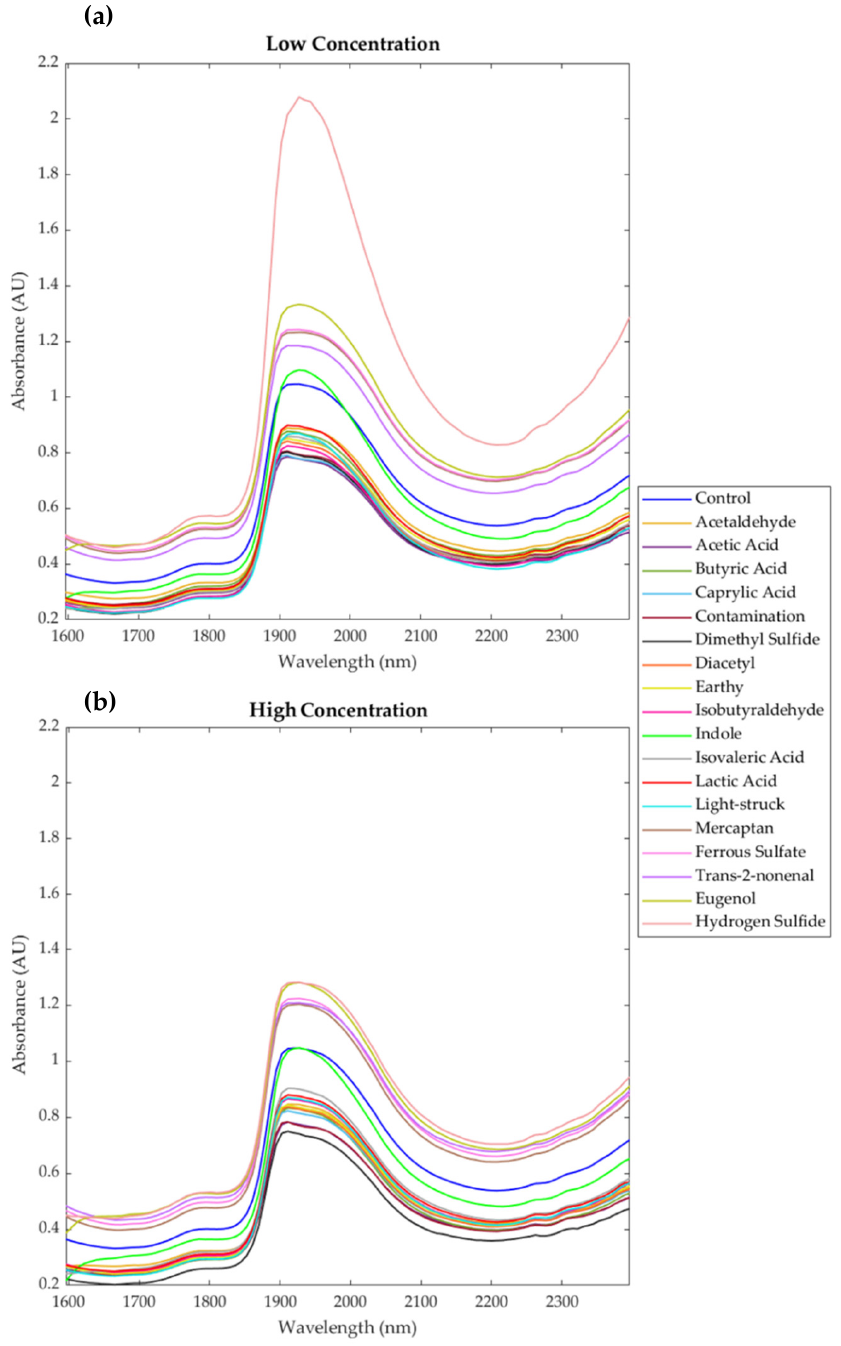
Figure 2. Near-infrared curves for all beer samples using the raw absorbance values at ( a ) low and ( b ) high concentrations.